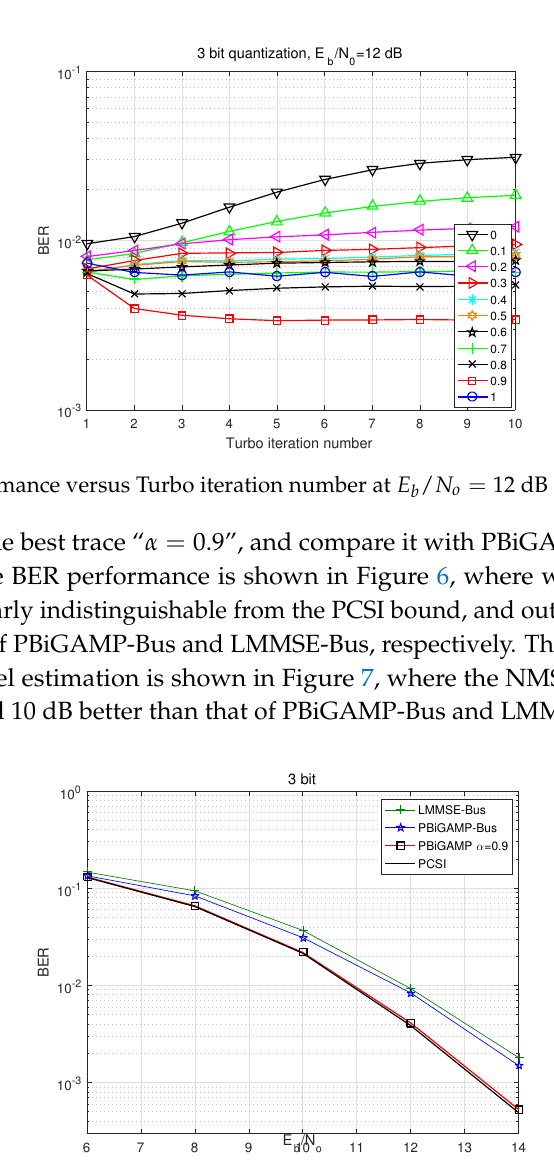
Figure 4. BER performance versus E b / N o at 10-th Turbo iteration for different values of α .